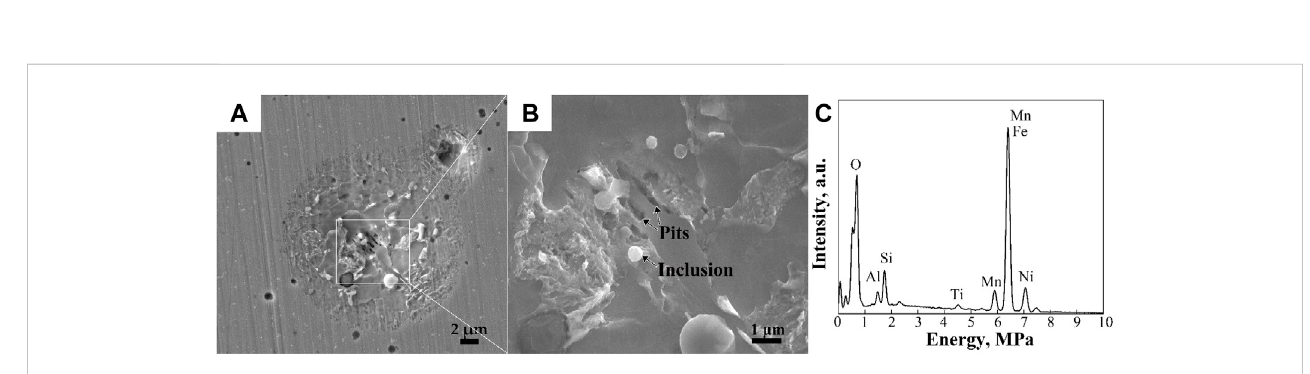
FIGURE 11 SEM morphology of corrosion in WM 2 at low (A) and high (B) magni fi cation and the EDS map (C) of the inclusion in (B) .